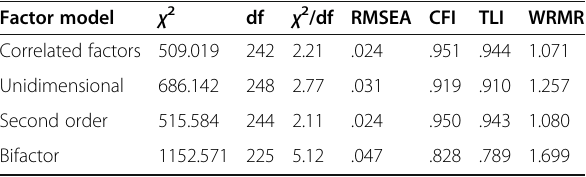
Table 5 Fit indices of the confirmatory factor analysis models describing SIT-PE